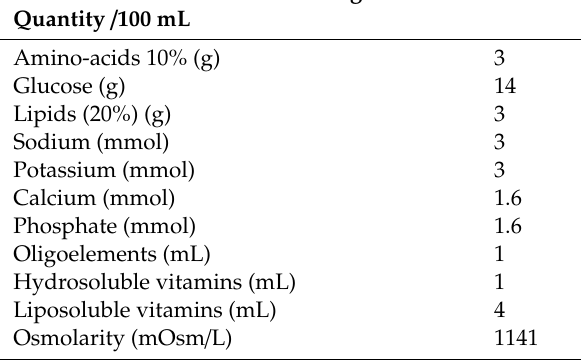
Table 5. Standard parenteral nutrition bag.